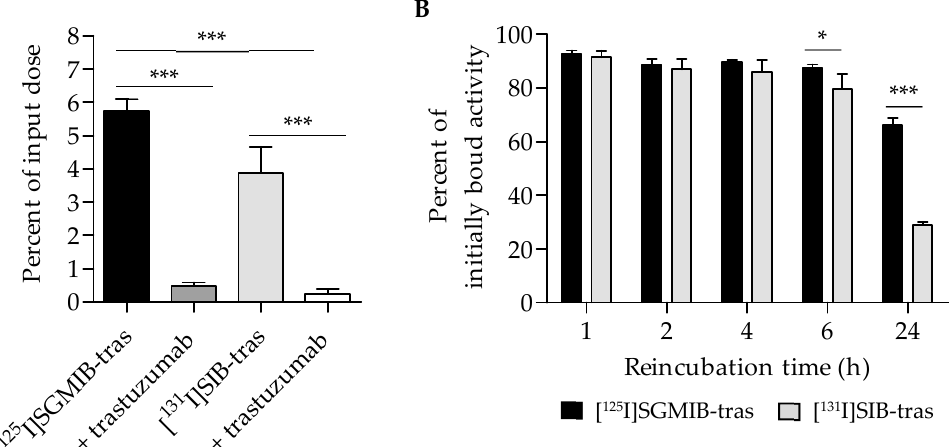
Figure 2. Paired-label studies of [ 125 I]SGMIB-trastuzumab and [ 131 I]SIB-trastuzumab in HER2-expressing BT474 cells in vitro. ( A ). Baseline uptake determined by incubating cells with the two labeled conjugates at 4 ◦ C for 1 h. ( B ). Percentage of initially bound radioactivity retained by the cells after incubation of cells with fresh medium at 37 ◦ C for various time points. * p < 0.05, *** p < 0.001.